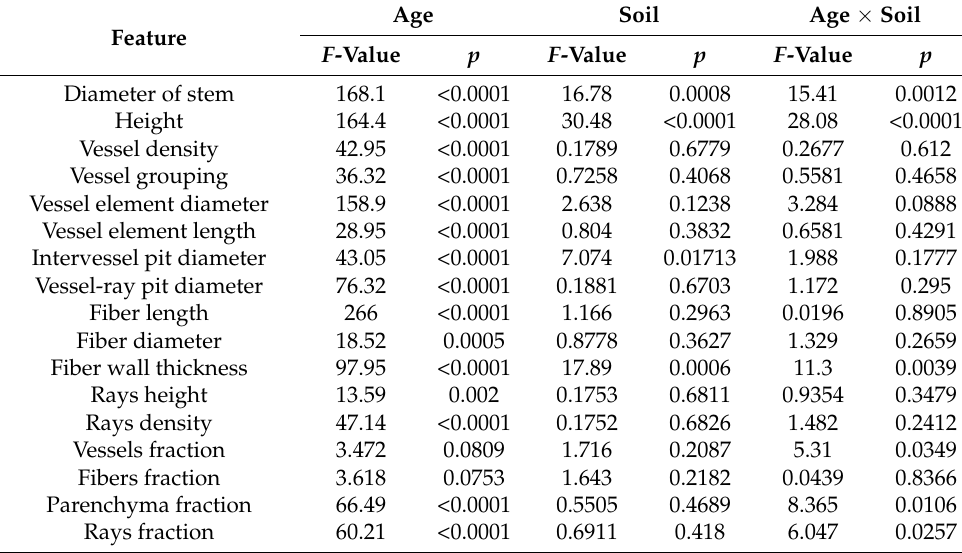
Table 4. Two-way ANOVA testing for the effect of age and soil on size and wood anatomy of Enterolobium contortisiliquum trees and saplings.